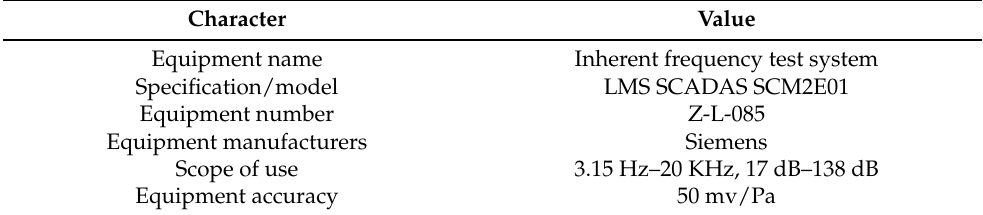
Figure 11. Mirror modal test equipment. Table 4. Test equipment